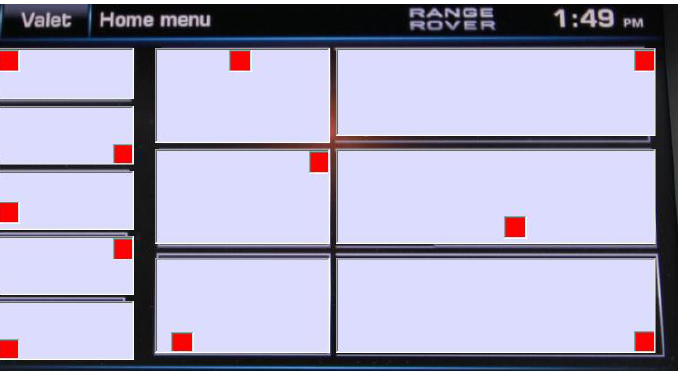
Figure 11. Final positions of hotspots after Simulated Annealing.